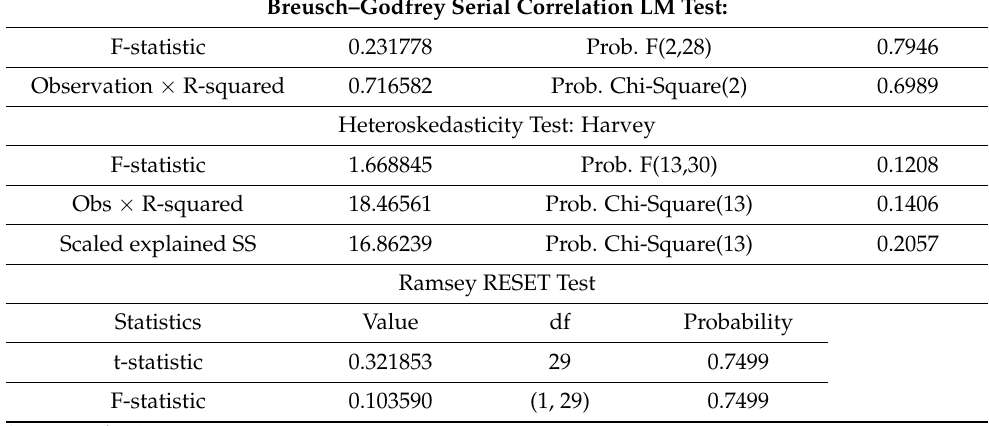
Table 8. Diagnostic Test Estimates.